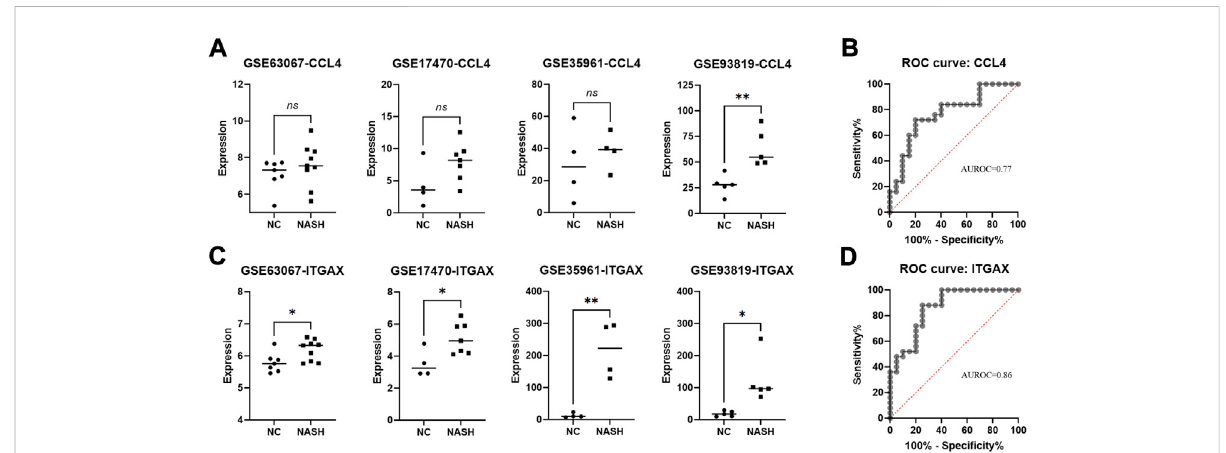
FIGURE 6 Identi fi cation of the CCL4 and ITGAX in four validation databases and investigation of its diagnosis value in NASH. (A) mRNA expression of CCL4 inNASHand normal samples was veri fi ed infour databases. (B) ROC curves of theCCL4in the validating set. (C) mRNA expressionof ITGAXin NASH and normal samples were veri fi ed in four databases. (D) ROC curves of ITGAX in the validating set. ns, non-signi fi cant; * p < 0.05 and *** p < 0.005 by t